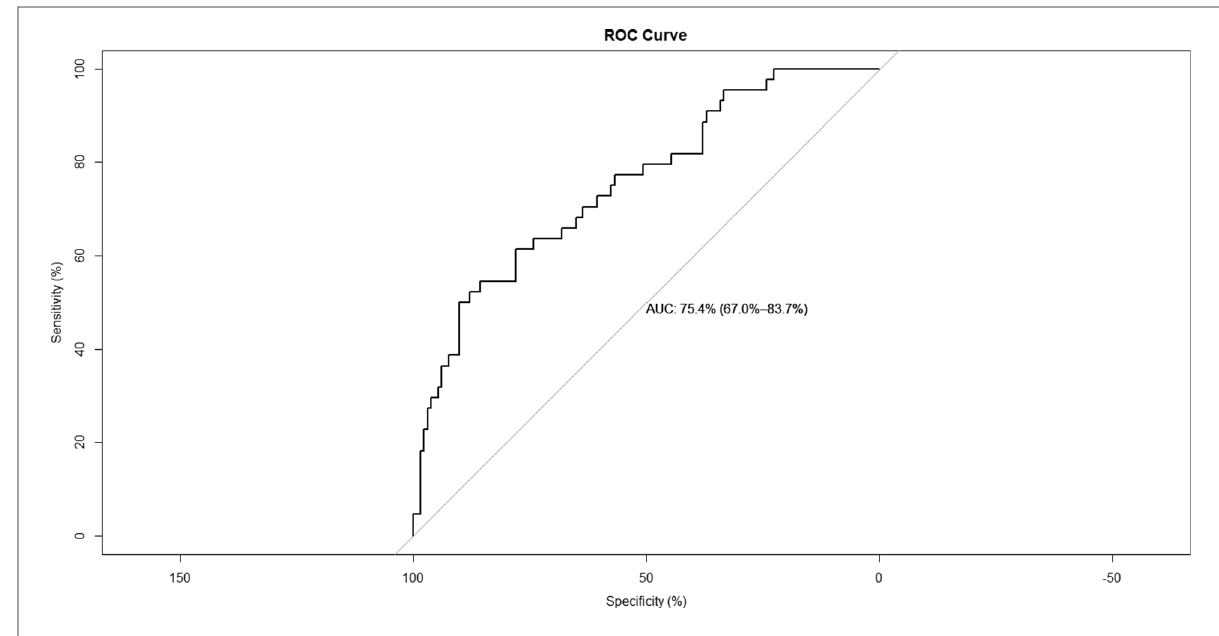
FIGURE 5 Receiver operating characteristic curve of the predictive